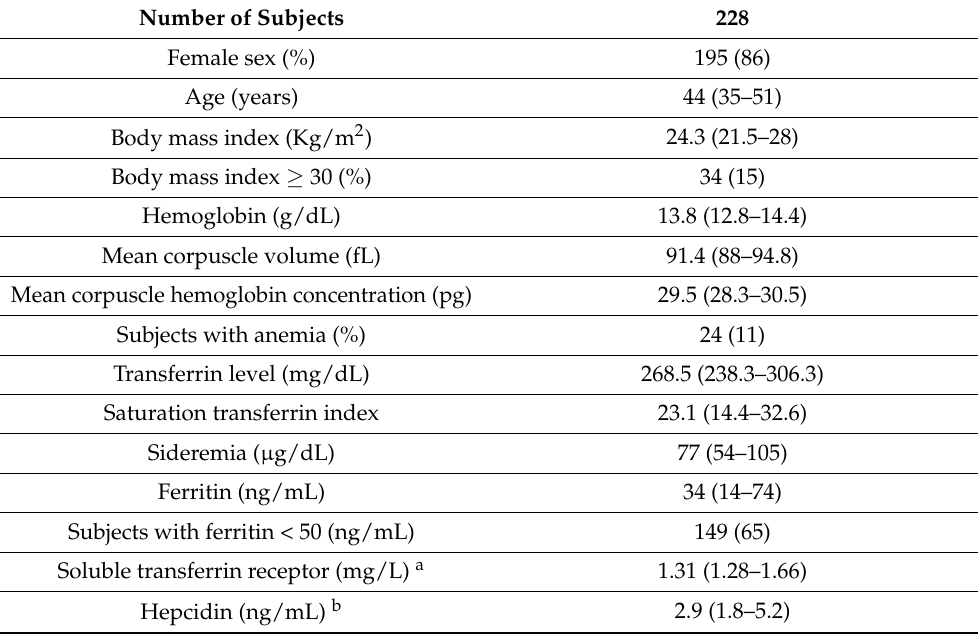
Table 1. Baseline characteristics of the